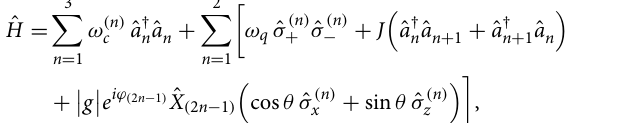
for the temporal pulse width δ t